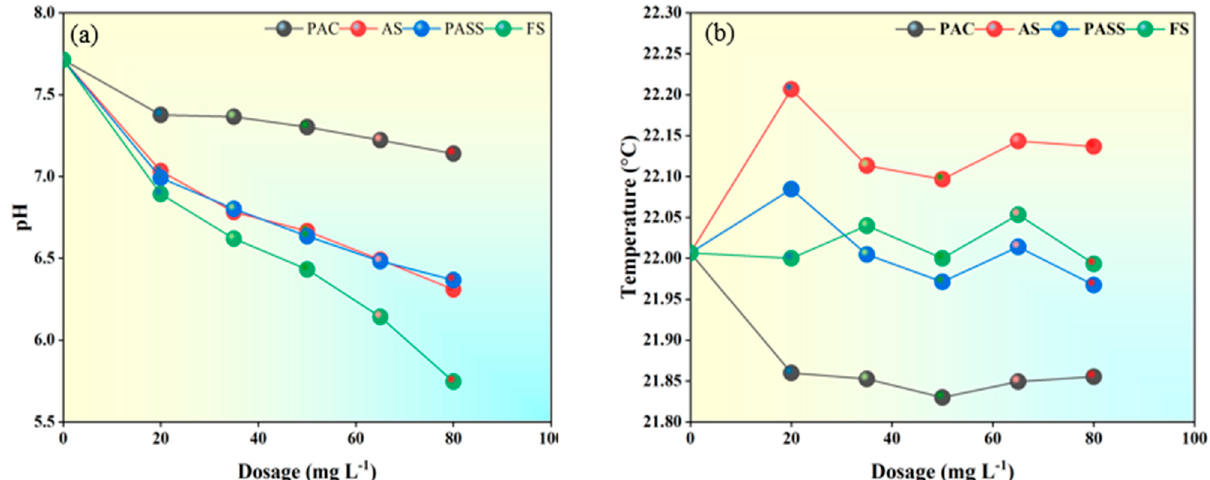
Figure 2. ( a ) pH and ( b ) temperature range as a function of each coagulant dose. Note(s): PAC = polyaluminium chloride; AS = aluminium sulfate; PASS = polyaluminium silicate sulfate; and FS = ferric sulfate.